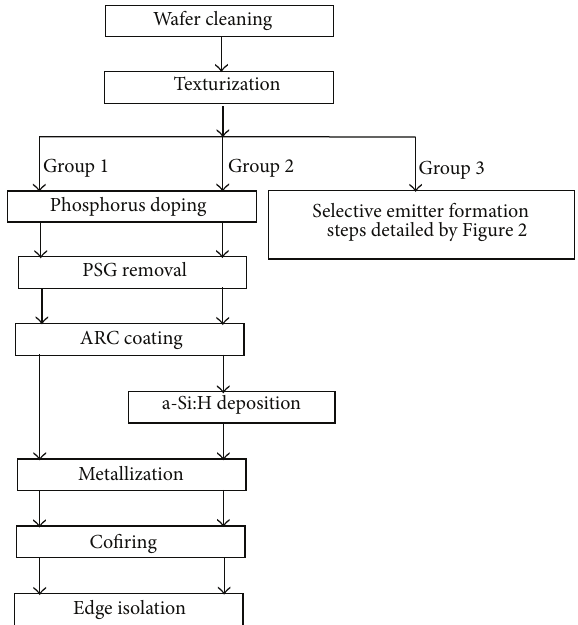
Figure 1: Fabrication steps for 3 groups of samples in this